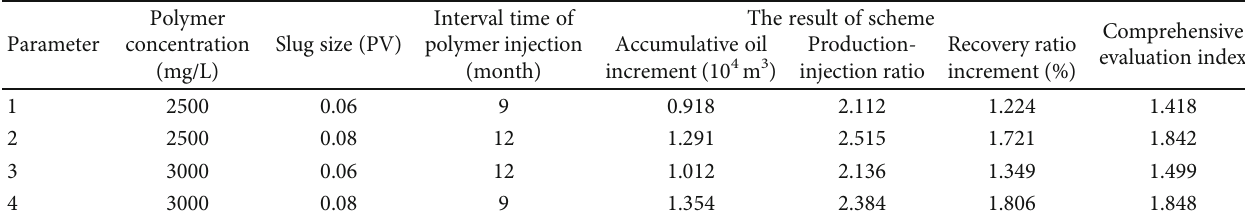
Table 3: The conformance control fl ooding scheme and e ff ect of B6 well